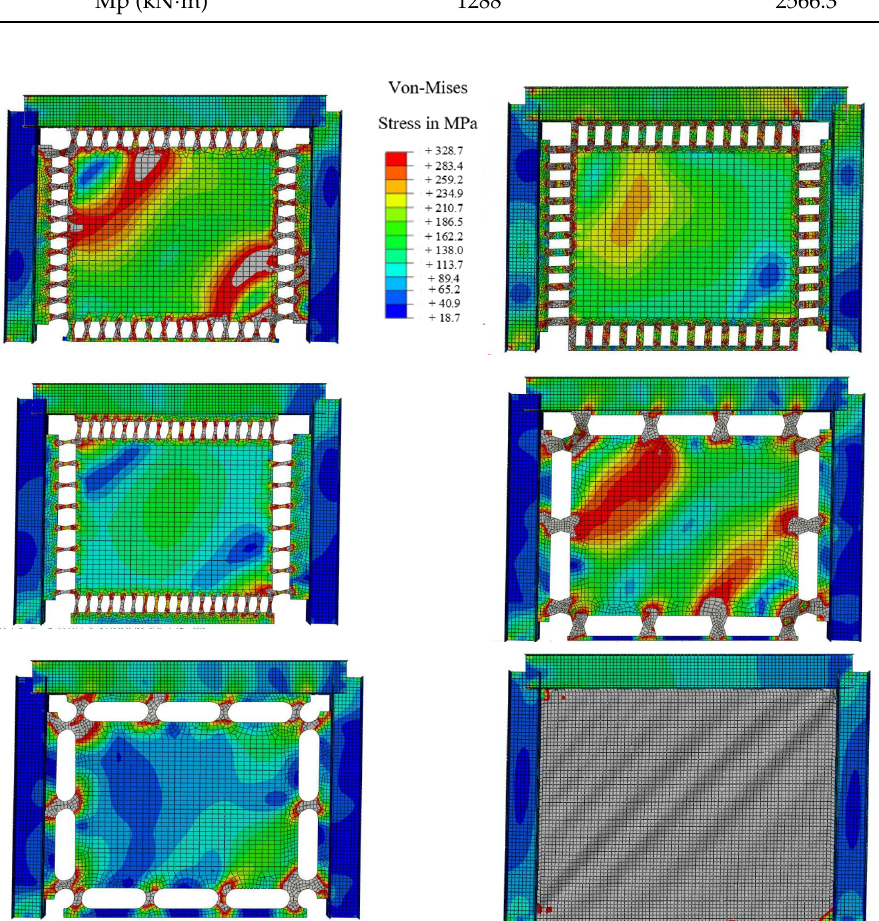
Figure 22. Von-Mises stress distribution for PRLs.